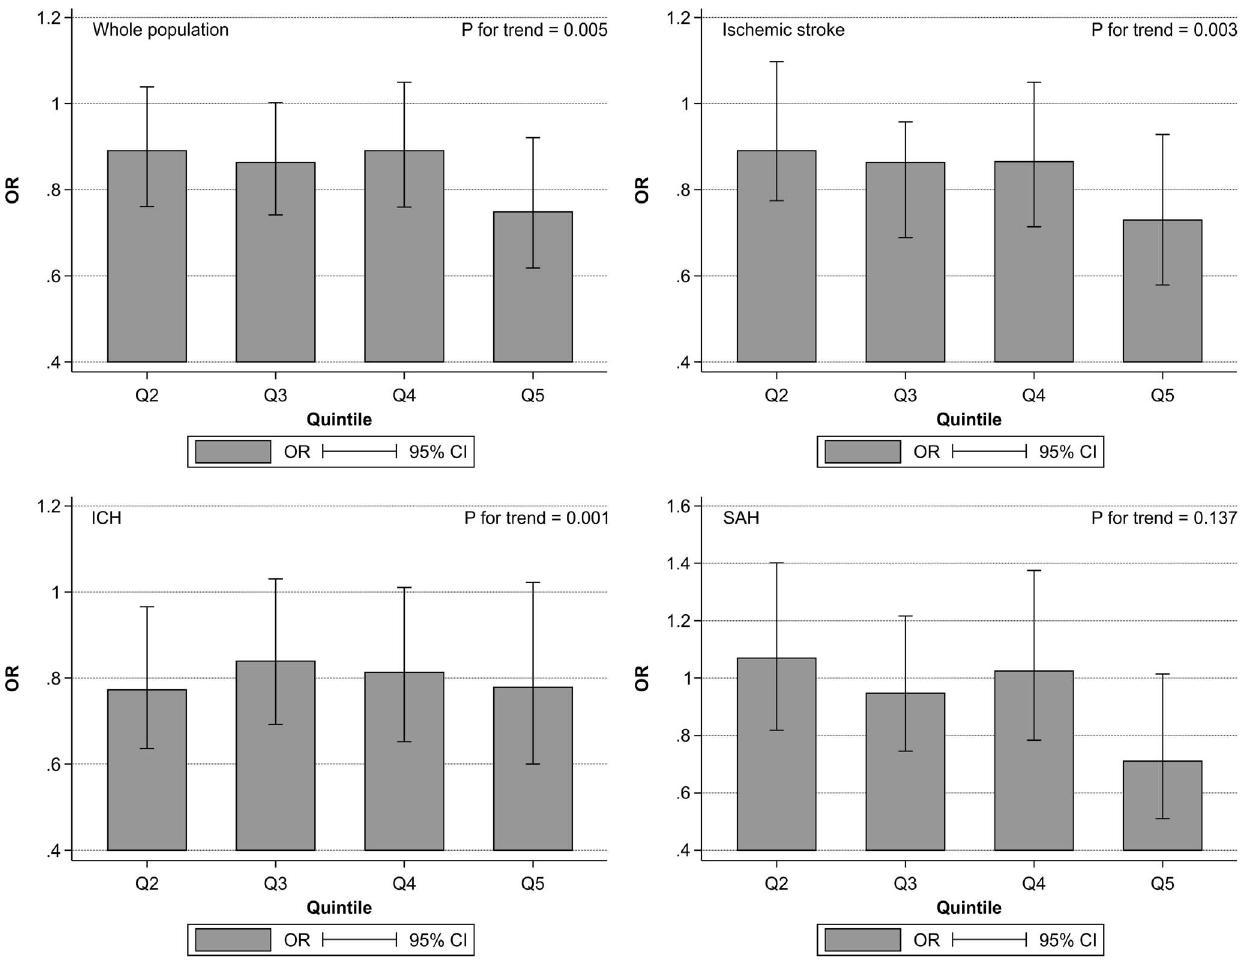
Figure 1. Associations between total comprehensive stroke care (CSC) scores separated into quintiles (Q1: 4–12, Q2: 13–14, Q3: 15– 17, Q4: 18, Q5: 19–23) and in-hospital mortality of patients after all types of stroke (a), ischemic stroke (b), intracerebral hemorrhage (ICH) (c), and subarachnoid hemorrhage (SAH) (d), after adjustment for age and sex. Odds ratios (ORs) and 95% confidence intervals (CIs) of in-hospital mortality of each total CSC score quintile are depicted compared with that of Q1 as control.